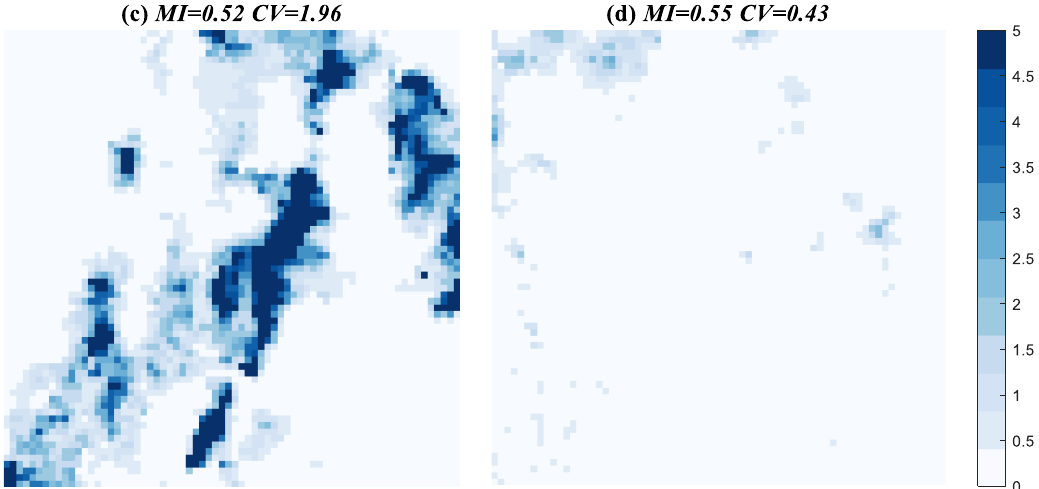
Figure 2. Radar rainfall (mm/h) images for four events with different spatial rainfall variability. ( a ) MI = 0.95, CV = 1.15, ( b ) MI = 0.12, CV = 1.37, ( c ) MI = 0.52, CV = 1.96, ( d ) MI = 0.55, CV = 0.43.